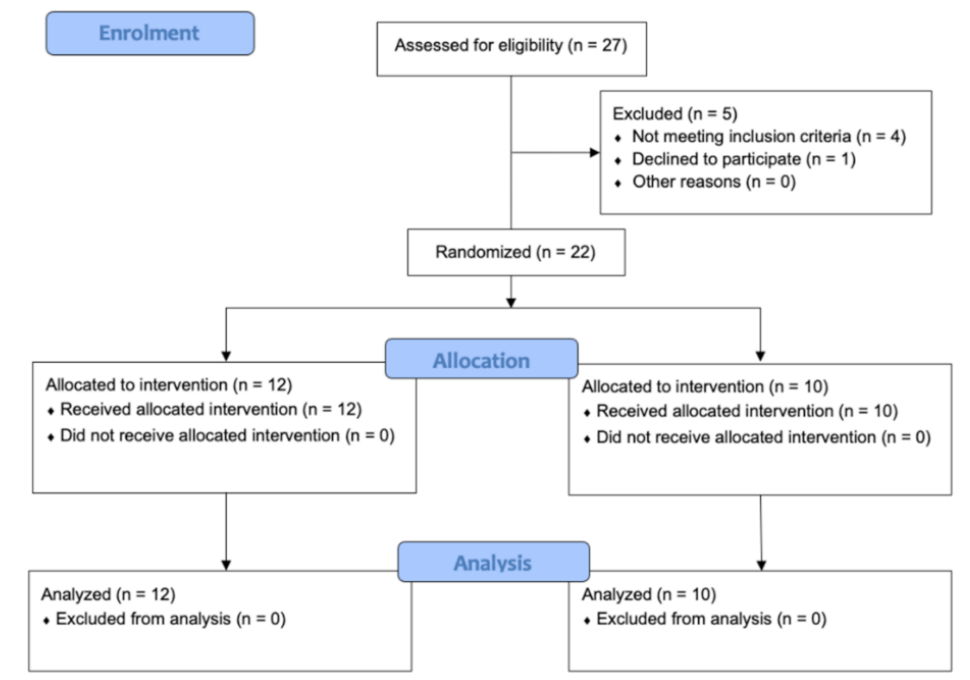
Figure 1. CONSORT flow